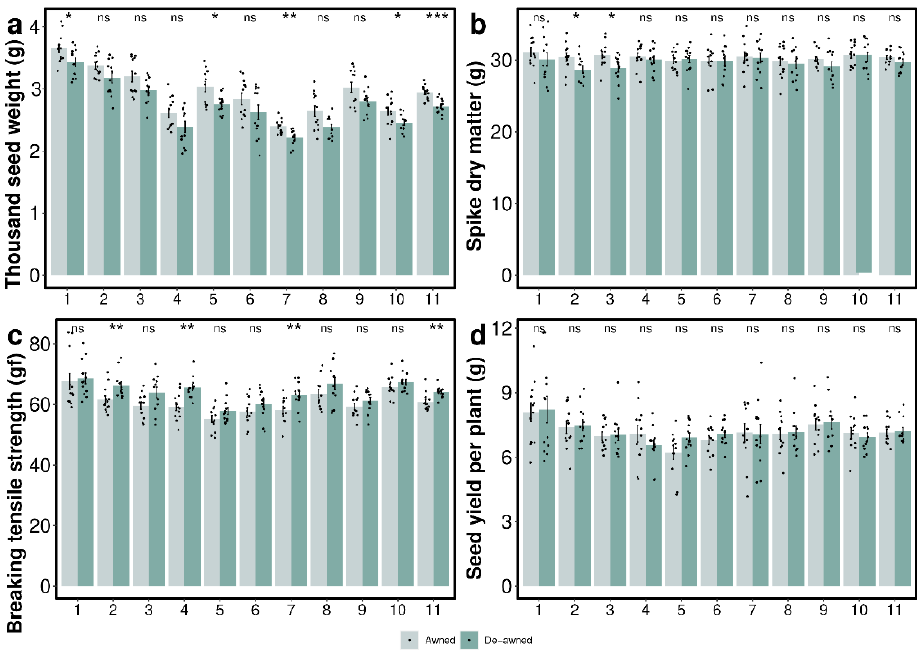
Figure 8. Thousand-seed weight ( a ), spike dry matter ( b ), breaking tensile strength ( c ), and seed yield per plant ( d ) of 10 Siberian wildrye accessions (1-10) and averages of accessions (11) under control and awn excision treatments across rainfed and irrigated conditions. Error bars represent mean ± standard deviation. ns: not significant, * p < 0.05, ** p < 0.01, *** p < 0.001.